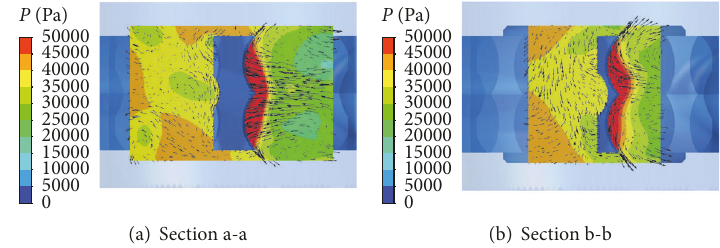
Figure 26: Static pressure distributions and absolute velocity vectors of Blade B ( 𝜃 ∗ = 48 ∘ , 𝑛 = 150 ,000 min −1 ).